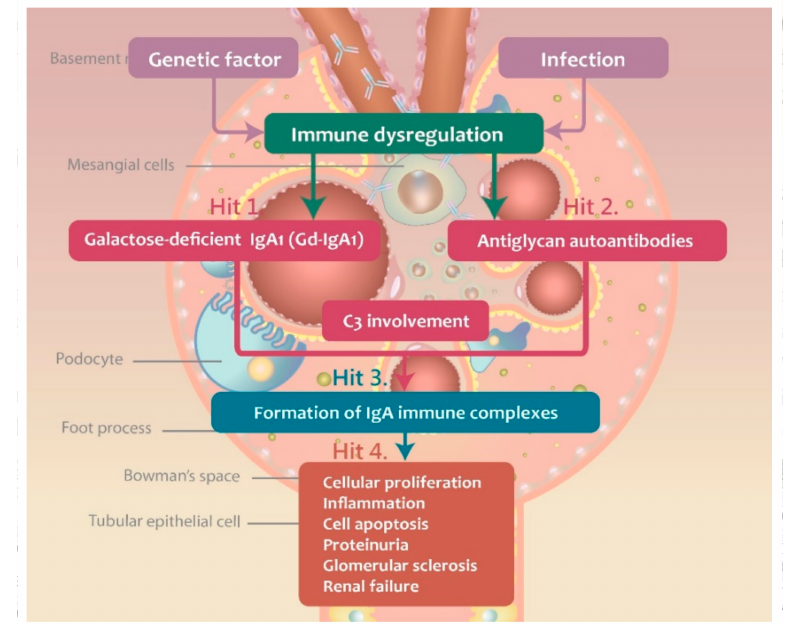
Figure 1. The multi-“hit” hypothesis explaining the immunopathogenesis of